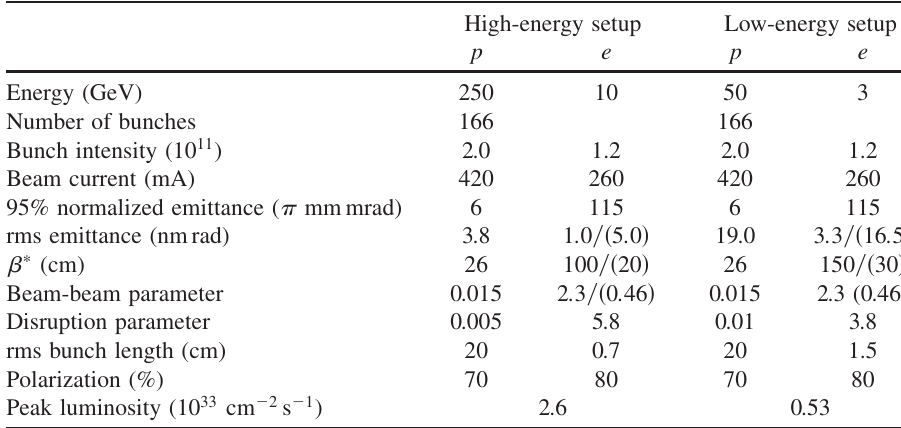
TABLE I. ERL-based eRHIC beam parameters. High-energy